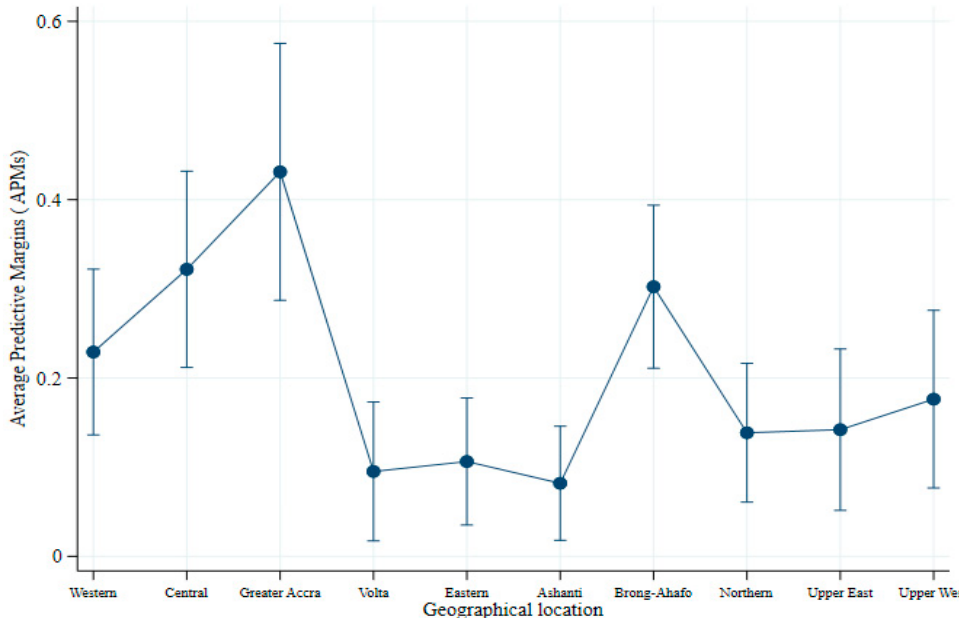
Figure 3. Average predictive margin of geographical location with 95% CIs.